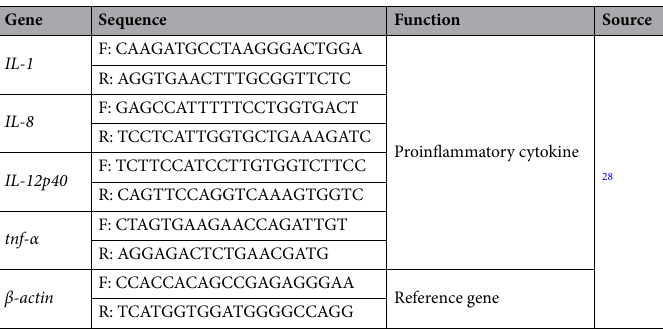
Table 3. Primers used for gene expression analysis.